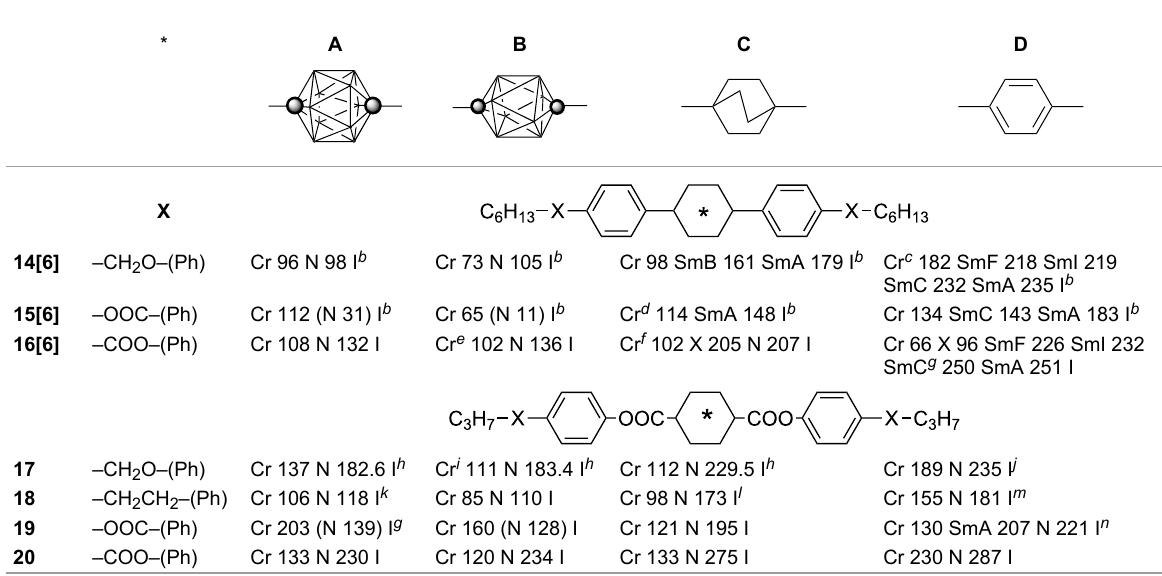
Table 1: Transition temperatures (°C) for selected liquid crystals. a * A B